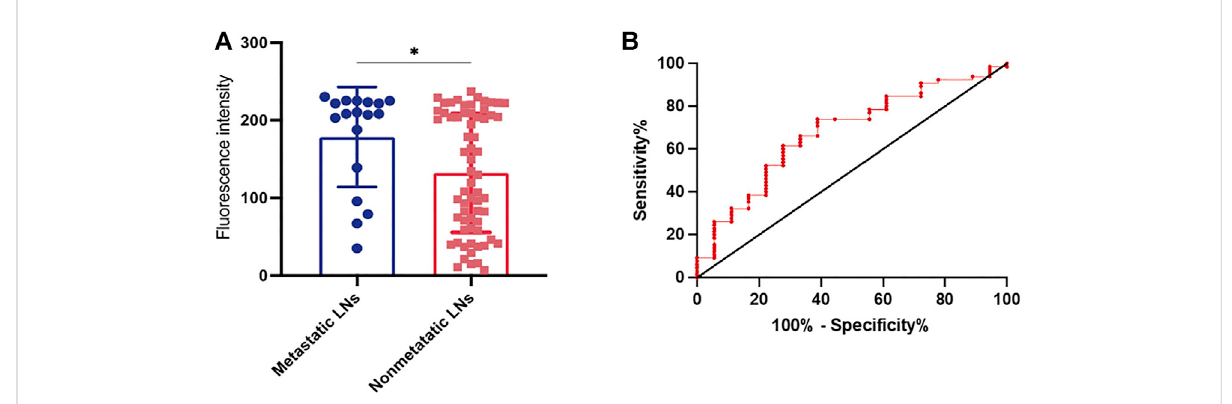
FIGURE 4 (A) The fl uorescenceintensityofmetastaticornon-metastaticLNsafterperitumoralinjectionofICG:HSA. (B) ROCcurveanalysisofthepatients receiving peritumoral injection of ICG: HSA. * P <